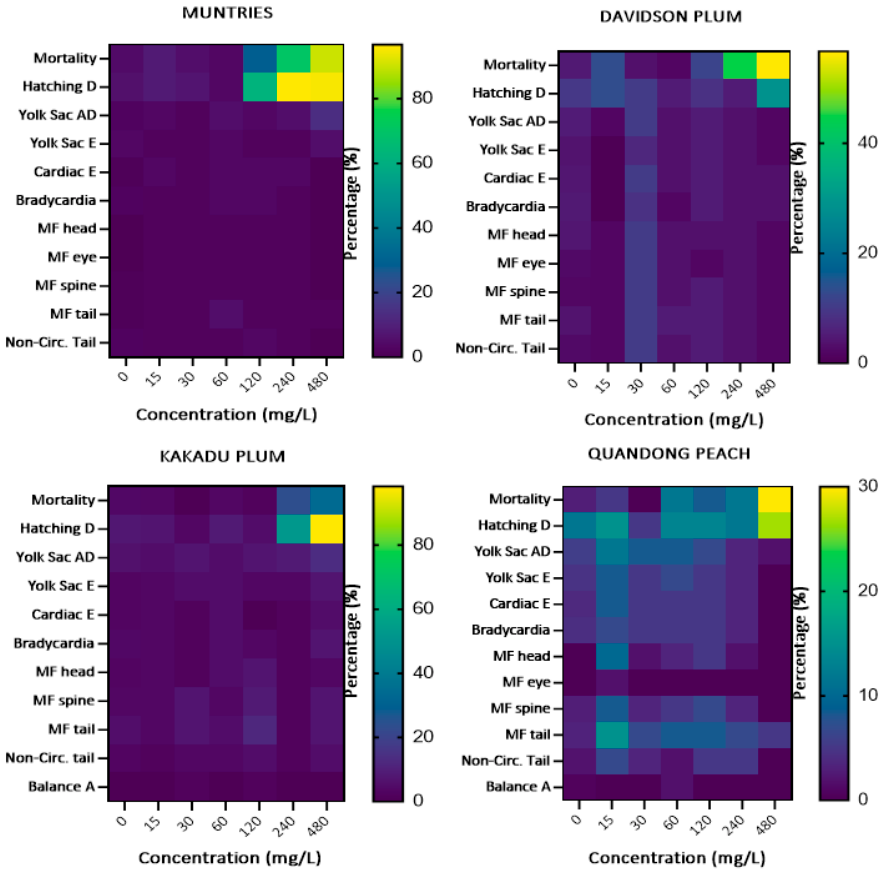
Figure 4. Heatmaps of the changes in zebrafish embryos during the exposure of Australian muntries, Davidson plum, Kakadu plum, and Davidson plum extracts at 96 h.